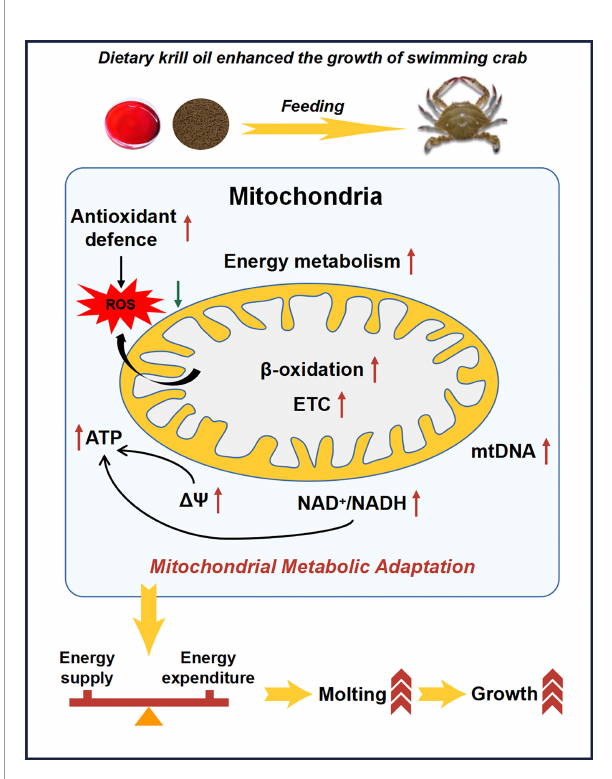
FIGURE 6 | Schematic of dietary krill oil greatly enhances the growth of swimming crab via promoting the mitochondrial metabolic adaptation and energy